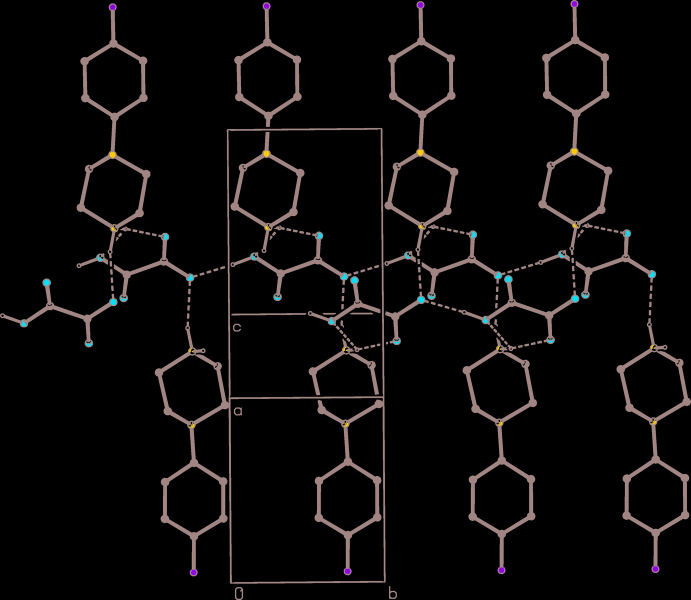
Part of the crystal structure of compound (II) showing the formation of a hydrogen-bonded chain of rings running parallel to the [010] direction. Hydrogen bonds are drawn as dashed lines and, for the sake of clarity, the H atoms bonded to C atoms have been omitted.